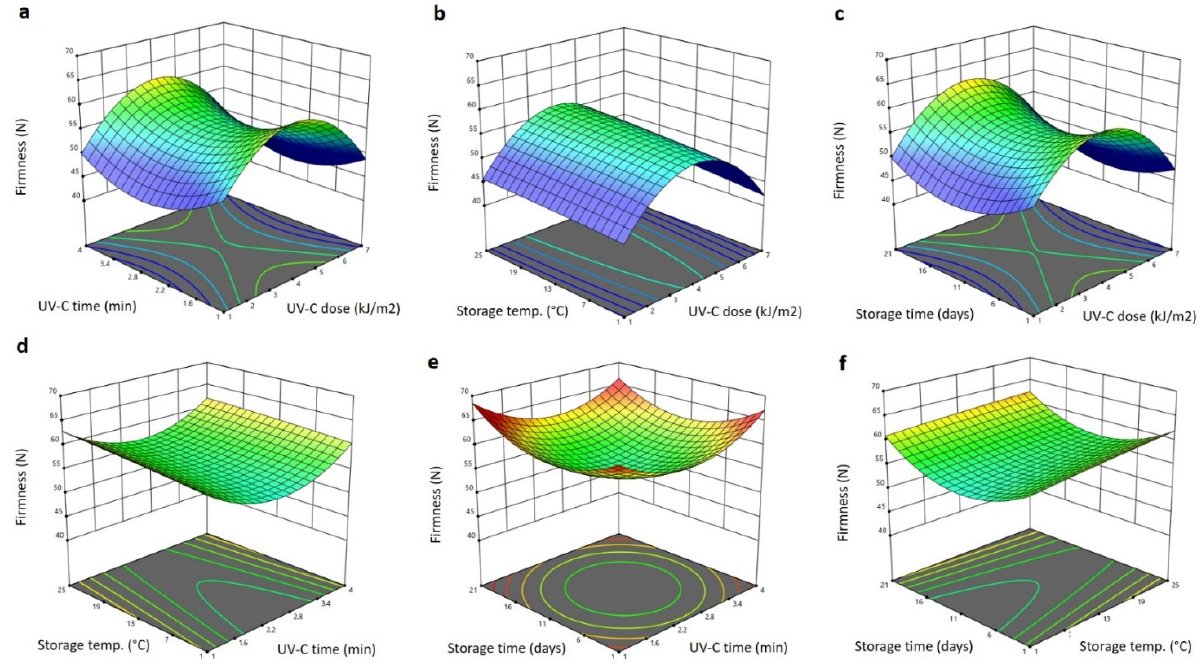
Figure 3. Response surface plots of firmness of Barhi dates as a function of UV-C time and UV-C dose ( a ), storage temperature and UV-C dose ( b ), storage time and UV-C dose ( c ), storage temperature and UV-C time ( d ), storage time and UV-C time ( e ), and storage time and storage temperature ( f ).